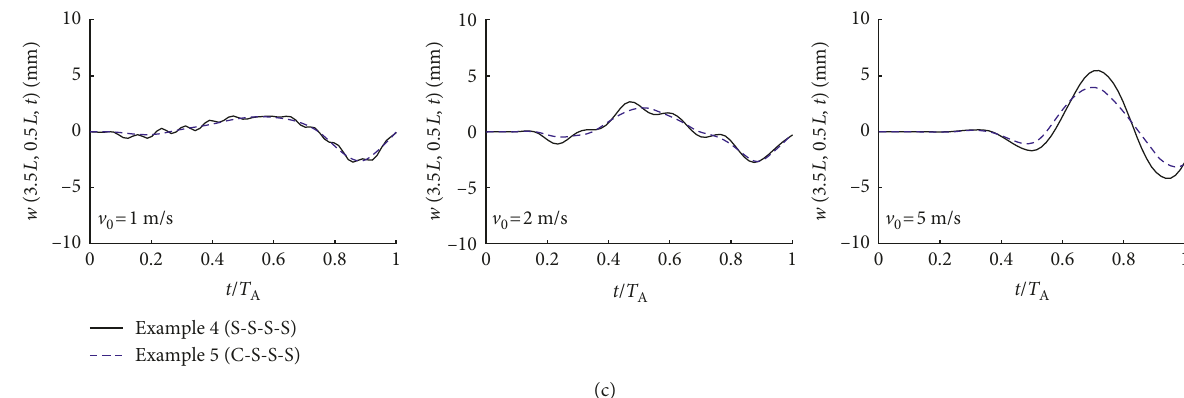
Figure 20: Effects of the boundary conditions on the vibration responses of two three-span rectangular plates subjected to a moving point force whose trajectory is given by (40). (a) At X